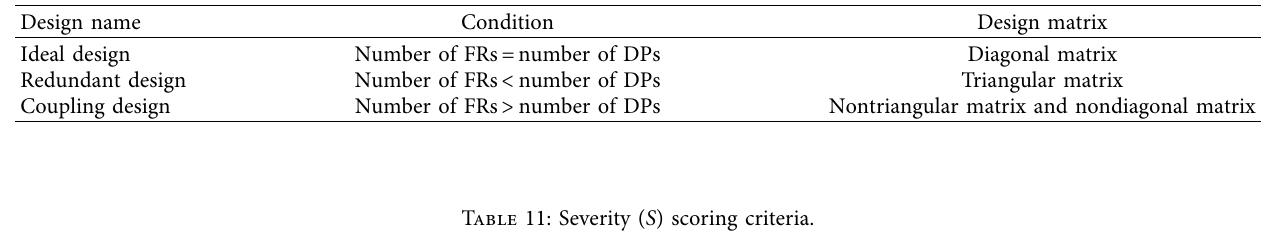
Table 10: Ideal, redundant, and coupling designs.